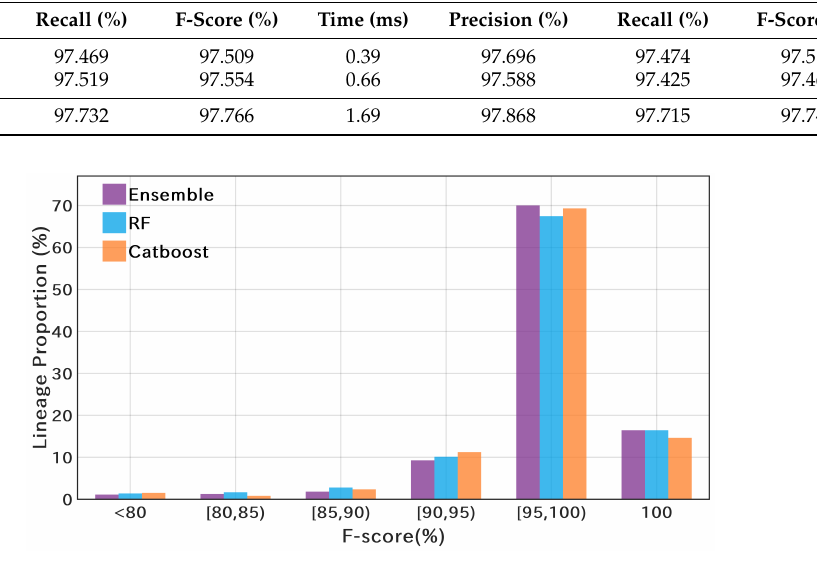
Figure 16. F-score distribution of different models on Pango lineage classification. The vertical axis represents the proportion of the Pango lineages in different F-score